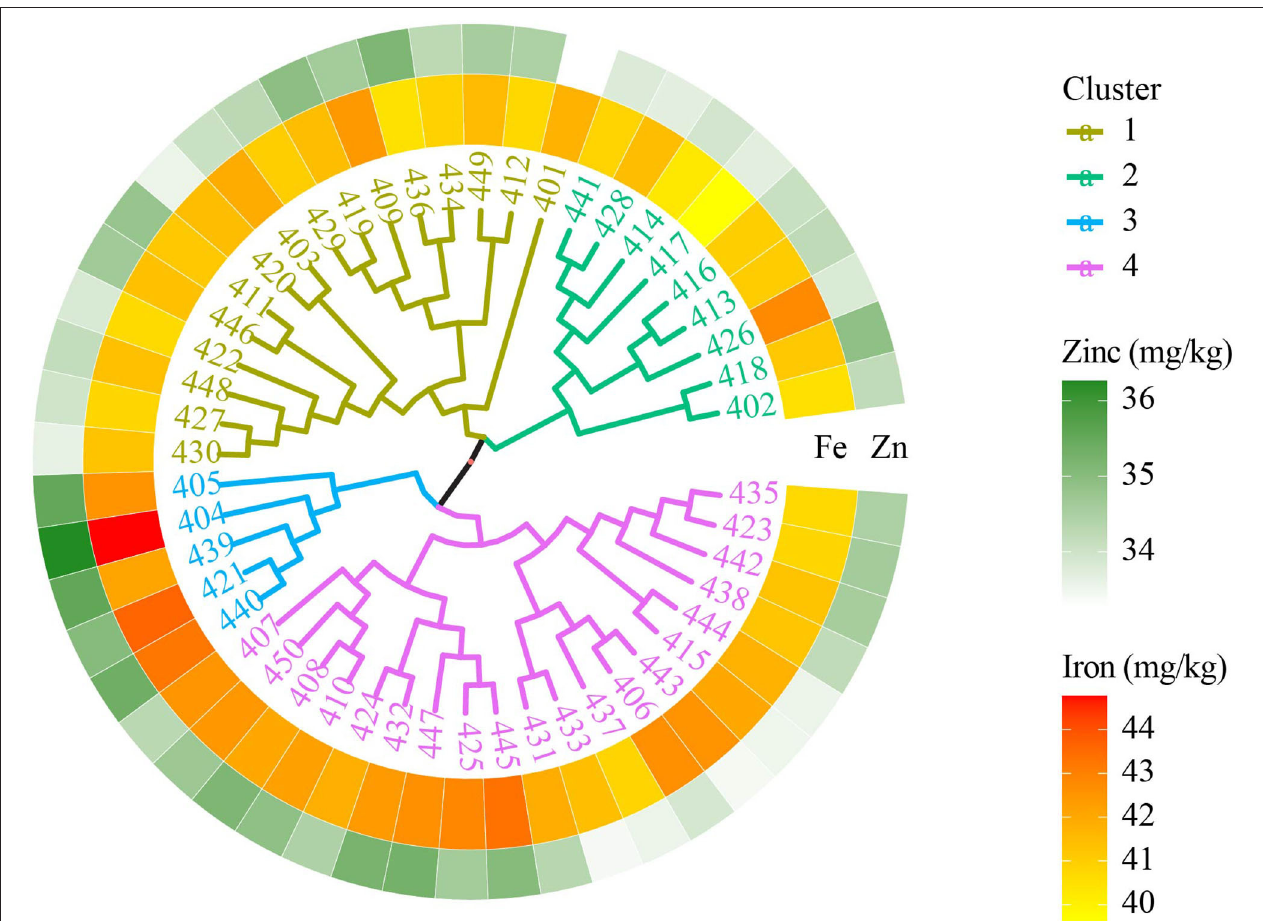
FIGURE 1 | Clustering of biofortified bread wheat genotypes from the 6th HPYT based on BLUP values.